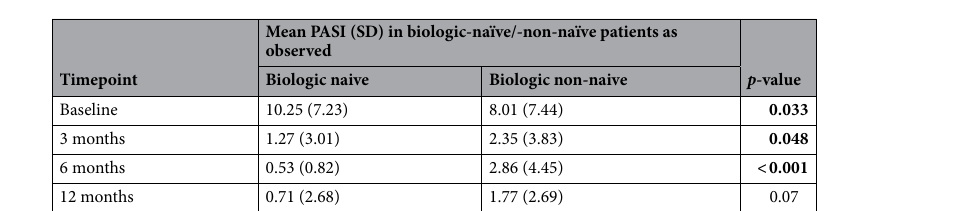
Figure 1. Effectiveness of IL-23 inhibitors in terms of absolute PASI. Absolute Psoriasis Area and Severity Index (PASI) value (± 95% confidence interval) plotted over time for patients analysed as observed ( a ) and per last observation carried forward (LOCF) ( b ).